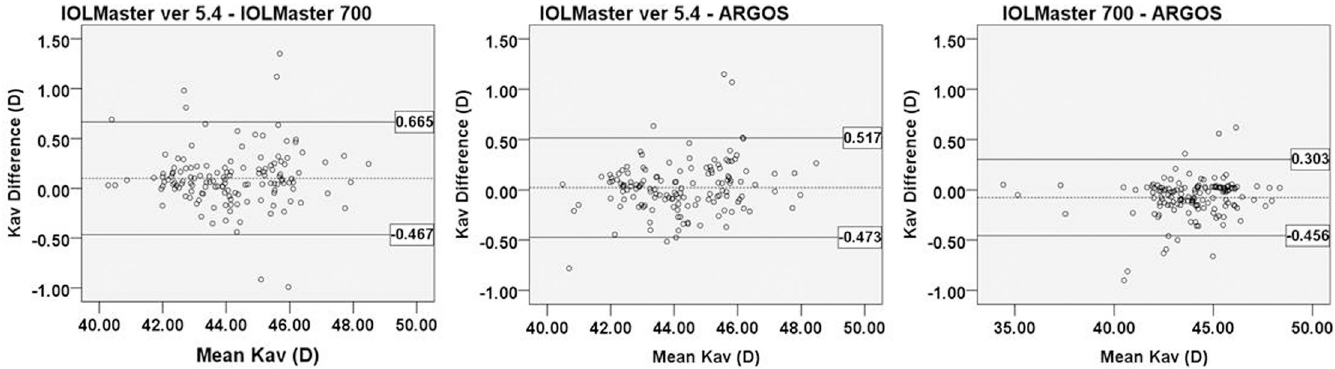
Fig 2. Bland-Altman plot of average keratometry measurements of each device. The mean difference is indicated by the dashed lines, and 95% LoA is indicated by the solid line. Comparison of IOLMaster ver. 5.4 and IOLMaster 700 (A); IOLMaster ver. 5.4 and Argos (B); and IOLMaster 700 and ARGOS (C). (Kav = average of keratometric